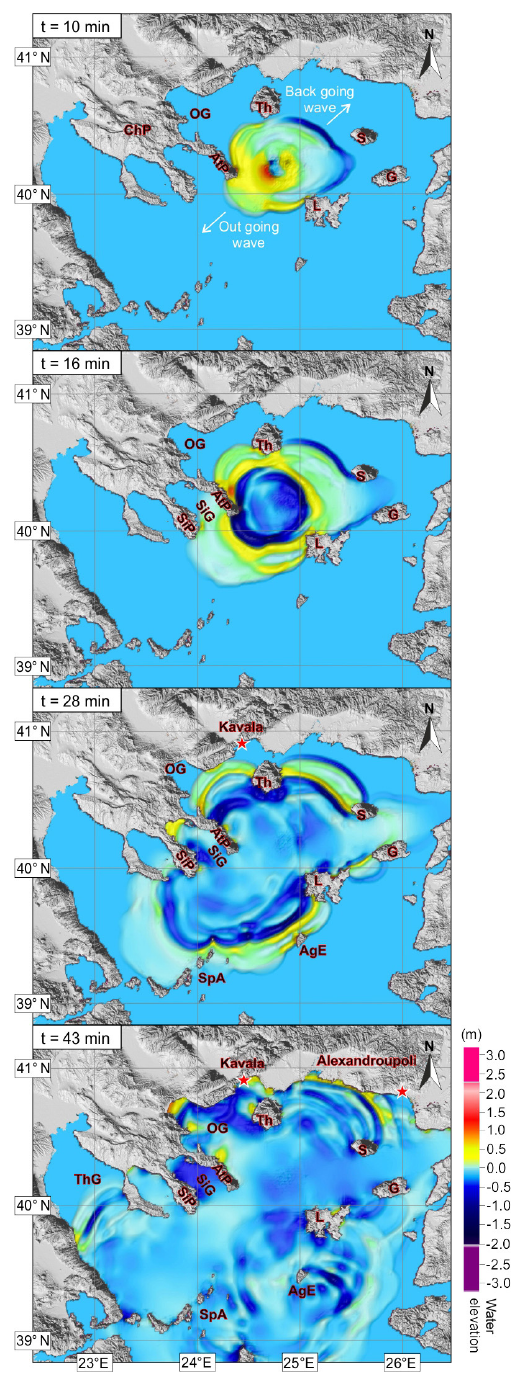
Figure 4. Tsunami propagation in the case of the first credible sce- nario. ( e w of 10 − 3 and a basal friction angle of 1 ◦ ; Table 1). AgE is Agios Efstratios, AtP is Athos peninsula, G is Gokceada, L is Lemnos, OG is Gulf of Orfani, S is Samothrace, SiG is Sigitikos Gulf, SiP is Sithonia peninsula, SpA is Sporades archipelago, Th is Thasos and ThG is Thermaic